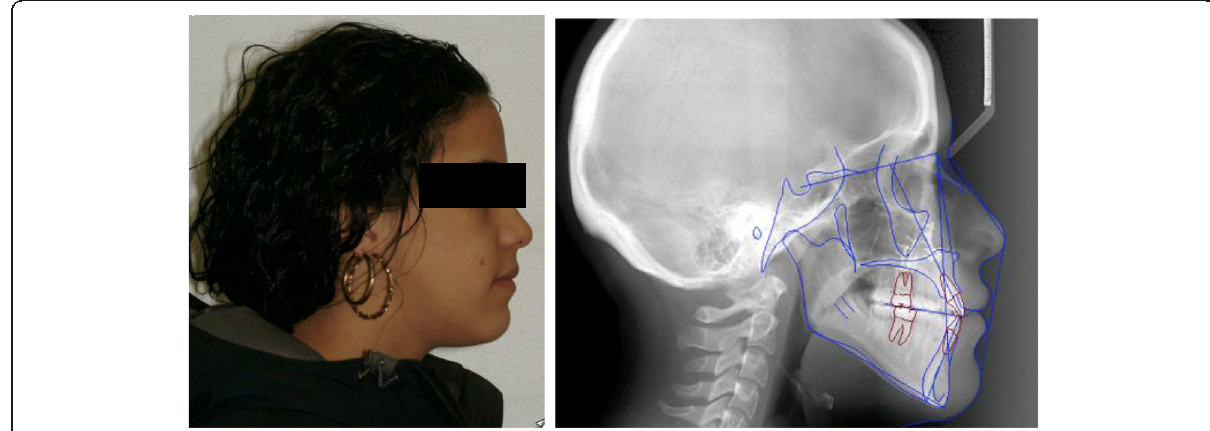
Fig. 2 Illustration of post-treatment profile photograph and traced cephalometric radiograph of a subject included in the sample